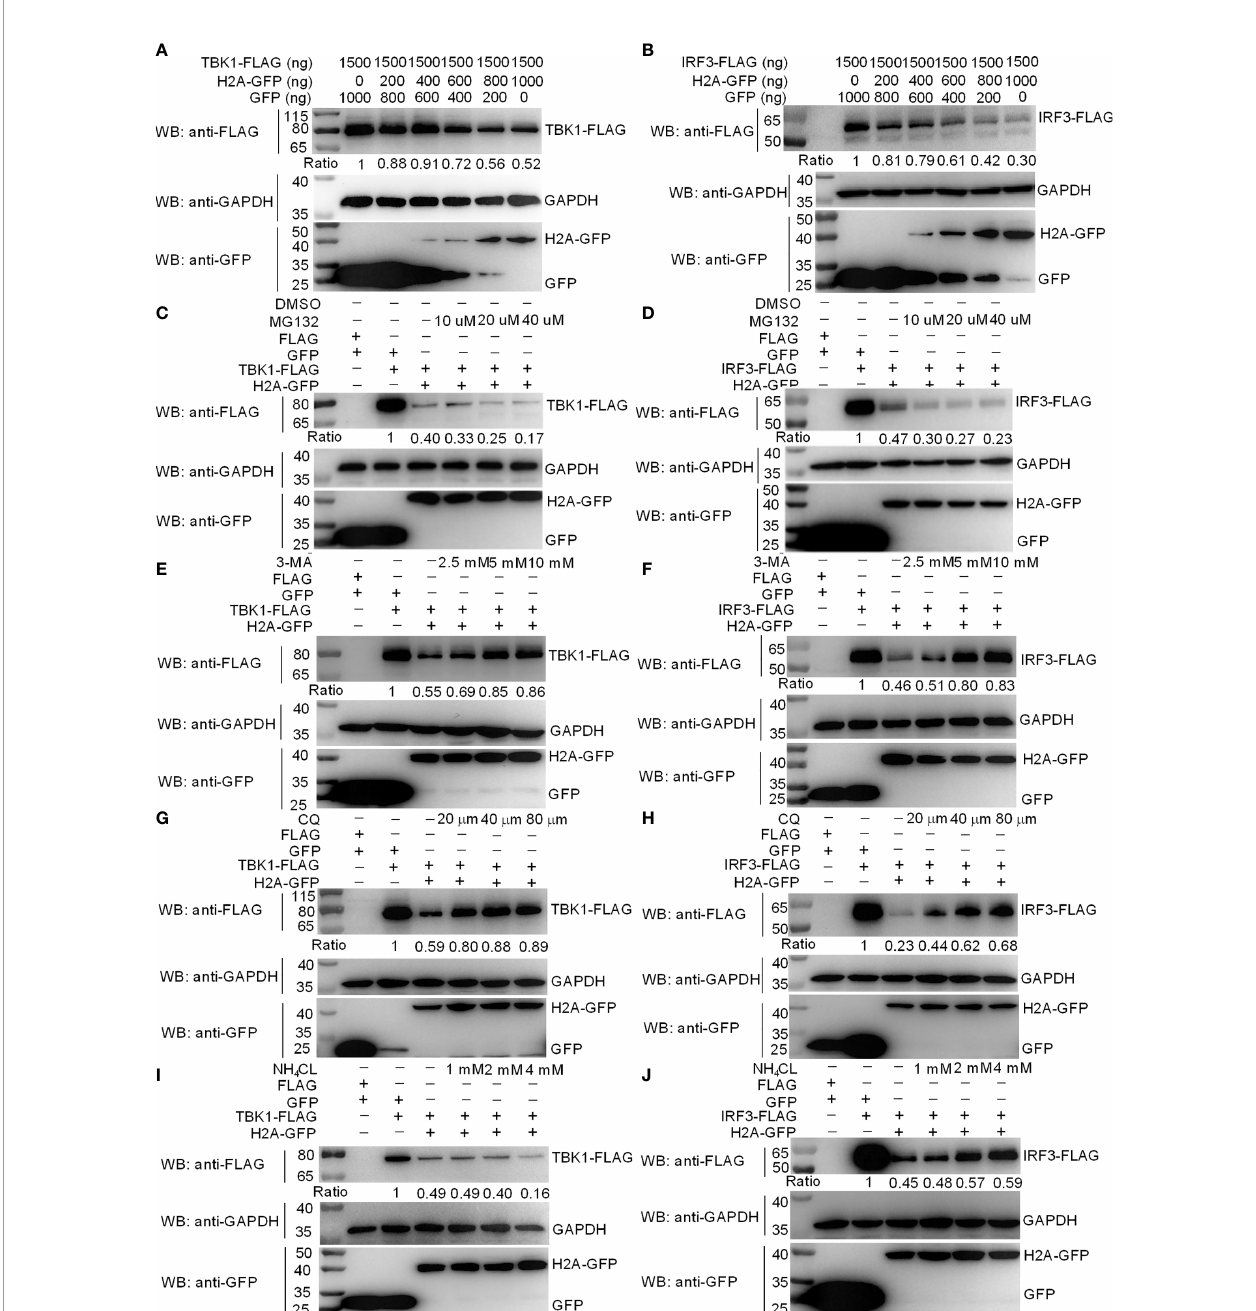
FIGURE 4 | Zebra fi sh histone H2A degrades TBK1 and IRF3 via the lysosomal pathway. (A) Effect of zebra fi sh histone H2A on the protein expression of TBK1. (B) Effect of zebra fi sh histone H2A on the protein expression of IRF3. For (A, B) , EPC cells seeded in six-well plates were transfected with various indicated plasmids and DNA concentration. After 48 h post-transfection, cell lysates were analyzed by Western blotting using the indicated Abs. (C) Effect of MG132 on the histone H2A-mediated protein degradation of TBK1. (D) Effect of MG132 on the histone H2A-mediated protein degradation of IRF3. (E) Effect of 3-MA on the histone H2A- mediated protein degradation of TBK1. (F) Effect of 3-MA on the histone H2A-mediated protein degradation of IRF3. (G) Effect of CQ on the histone H2A-mediated protein degradation of TBK1. (H) Effect of CQ on the histone H2A-mediated protein degradation of IRF3. (I) Effect of NH 4 Cl on the histone H2A-mediated protein degradation of TBK1. (J) Effect of NH 4 Cl on the histone H2A-mediated protein degradation of IRF3. For (C – J) , EPC cells seeded in six-well plates were transfected with various indicated plasmids and DNA concentration. After 48 h post-transfection, cells were treated with DMSO, MG132, 3-MA, CQ or NH 4 Cl with indicated concentration for 6 h. Following this, cell lysates were analyzed by Western blotting using the indicated Abs. The expression ratio for TBK1 or IRF3 protein was quanti fi ed by Quantity One. All experiments were repeated for at least three times with similar